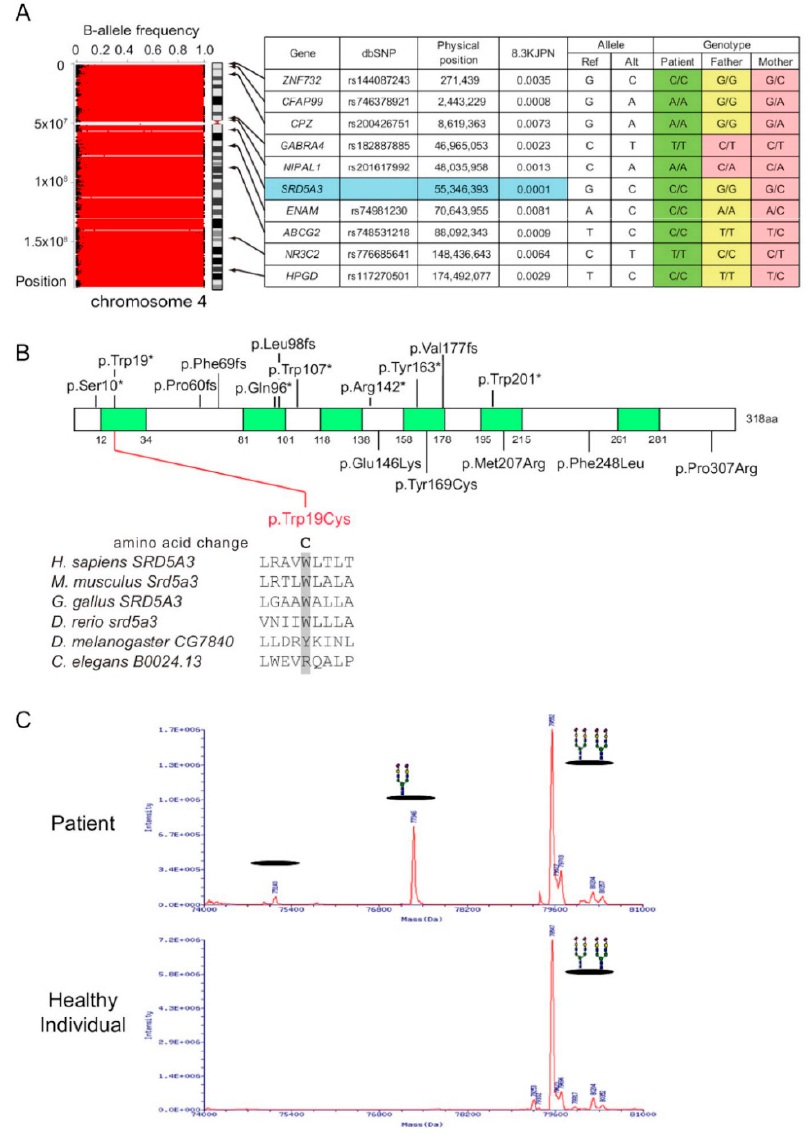
Figure 2. Findings of genetic and glycosylation analyses in patient 1. ( A ) (Left) H3M2 analysis using WES data showed LOH stretches on the whole of chromosome 4. (Right) Gene name, physical position, allele frequency in 8.3KJPN, and genotypes of the patient and her parents with 10 candidate variants are shown. Homozygous for reference allele, homozygous for alternate allele, and heterozygous genotypes are highlighted in yellow, green, and pink, respectively. Trio genotypes demonstrated maternal uniparental isodisomy. ( B ) Locations of reported SRD5A3 variants. Human SRD5A3 is 318 aa in length (NP_078868.1) and contains six putative transmembrane domains according to